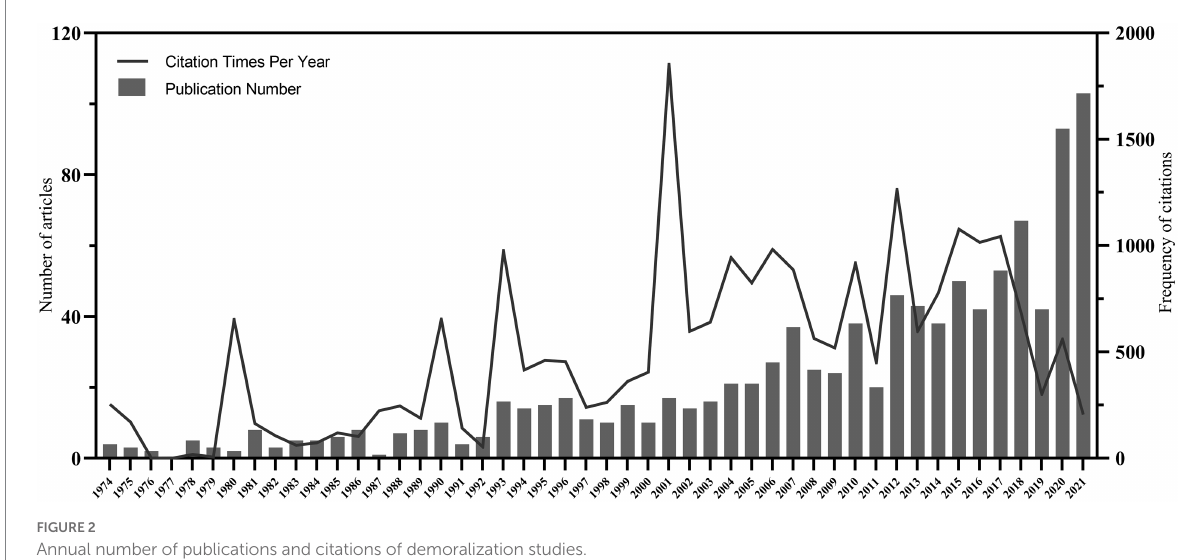
FIGURE 2 Annual number of publications and citations of demoralization studies.